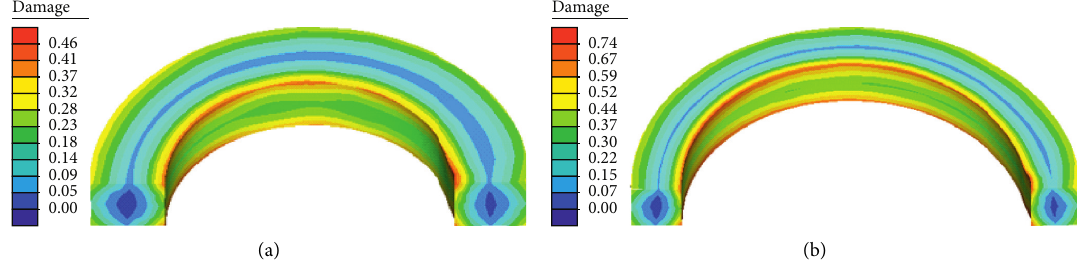
Figure 12: Damage value C distribution in hot ring rolling. (a) In the middle. (b) At the end of the